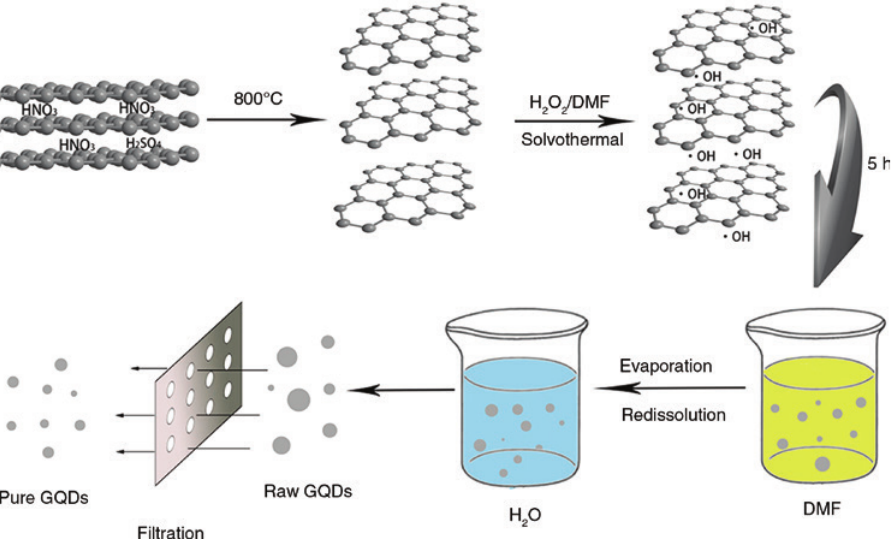
Figure 6: Schematic representation of GQDs prepared by solvothermal method (reprinted/reproduced with the permission of Ref. [69], copyright 2016, Elsevier